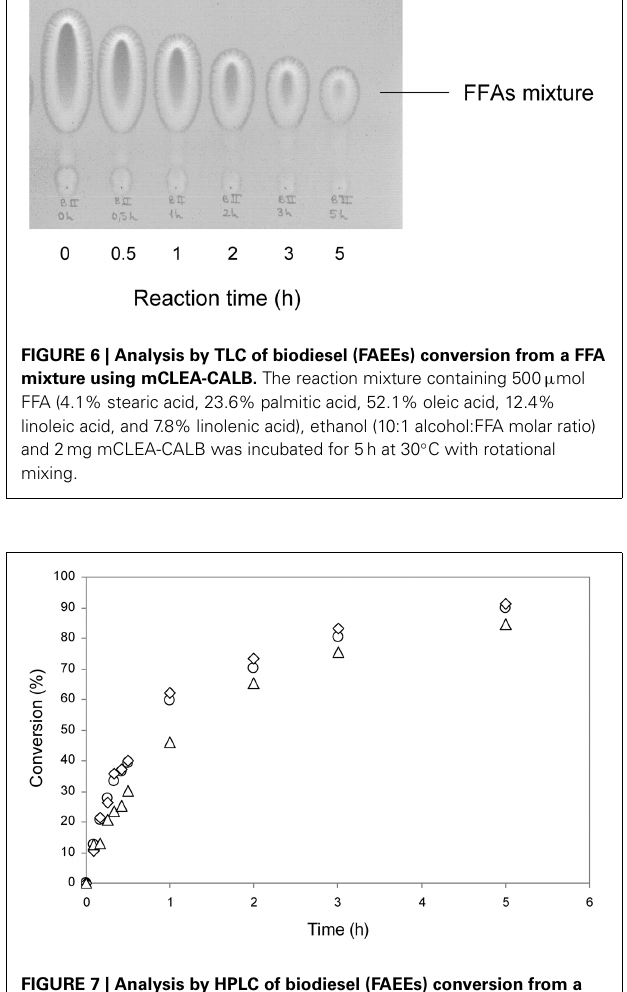
sugar and non-polar fatty acid donor could be soluble. Some